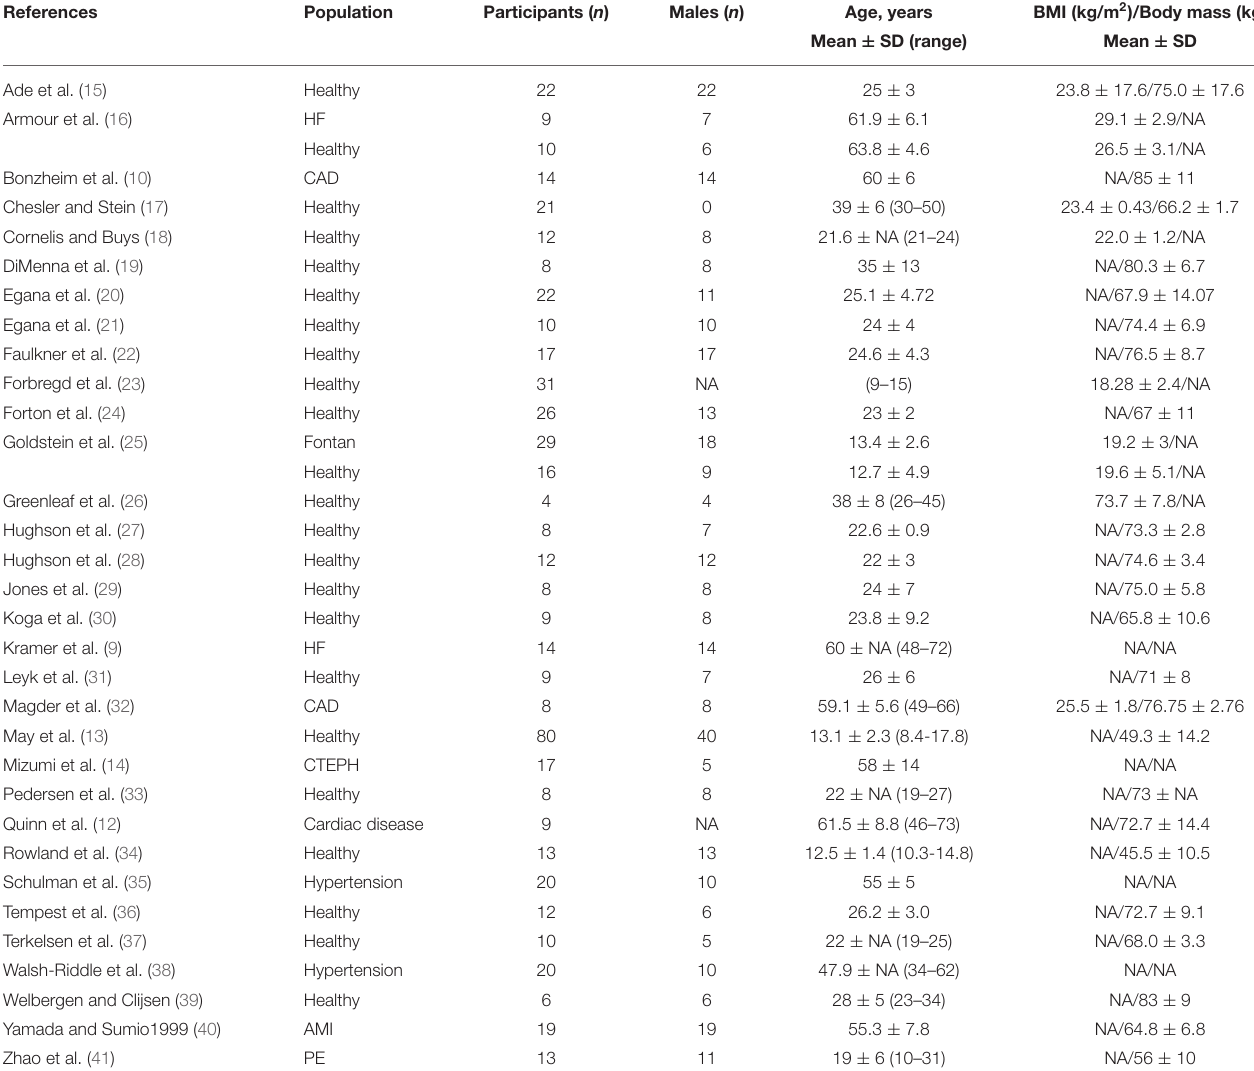
TABLE 2 | Characteristics of participants for the included studies ( n =